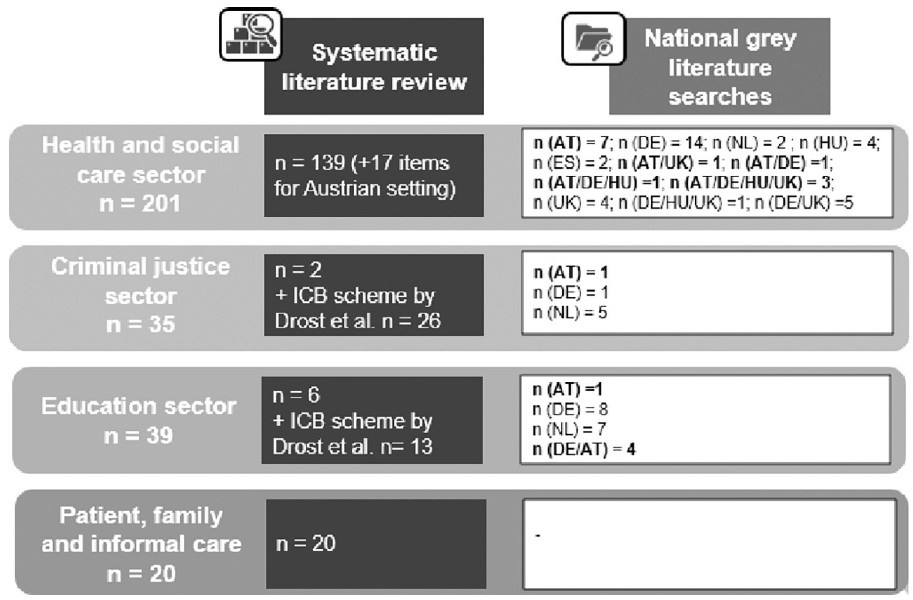
Fig 2. Sources of items in the preliminary, international sector-specific lists. Abbreviations: AT–Austria, DE– Germany, NL–the Netherlands, HU- Hungary, ES–Spain, UK–United Kingdom, ICB–inter-sectoral costs and benefits.